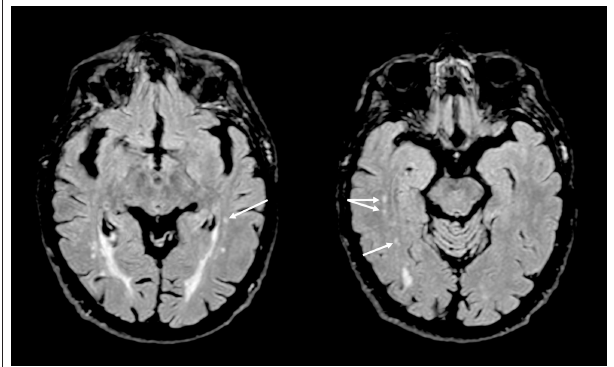
FIGURE 3 | Axial T2-weighted fluid-attenuated inversion recovery (FLAIR) images showing small gliotic foci in deep white matter of both temporal lobes (arrows) in a patient with burning mouth